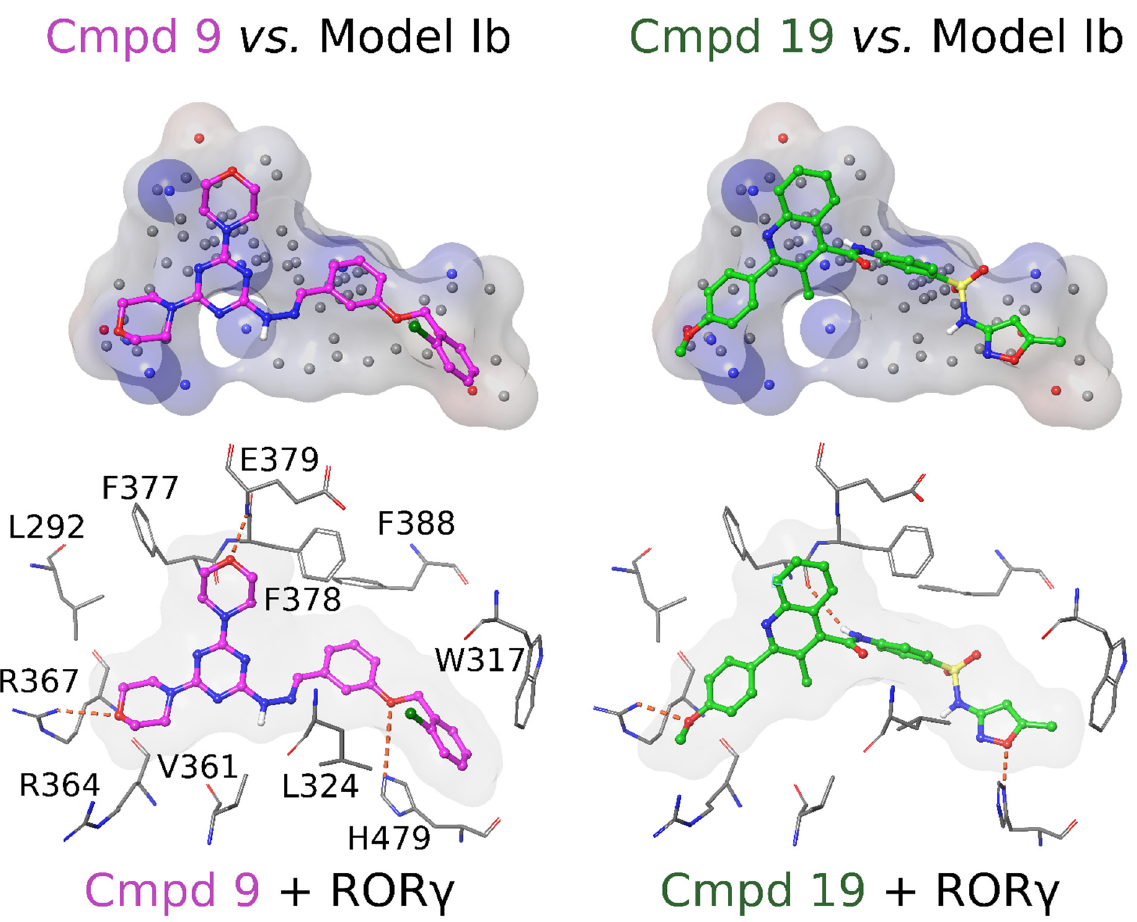
Figure 8. The proposed binding modes of compounds 9 and 19 with ROR γ t. On the top, both compounds 9 and 19 (ball-and-stick model with magenta/green carbons) show a high level of shape similarity with the BR-NiB-optimized Model Ib (transparent surface with electrostatic potential). Below, both of these compounds (gray shape-filling surface shown in the background) are also predicted to form H-bonds (orange dotted lines) with the key residues lining the ROR γ t binding cavity. For clarity, all hydrogens are omitted except for non-polar hydrogens of the compounds. See Figure 2 for further